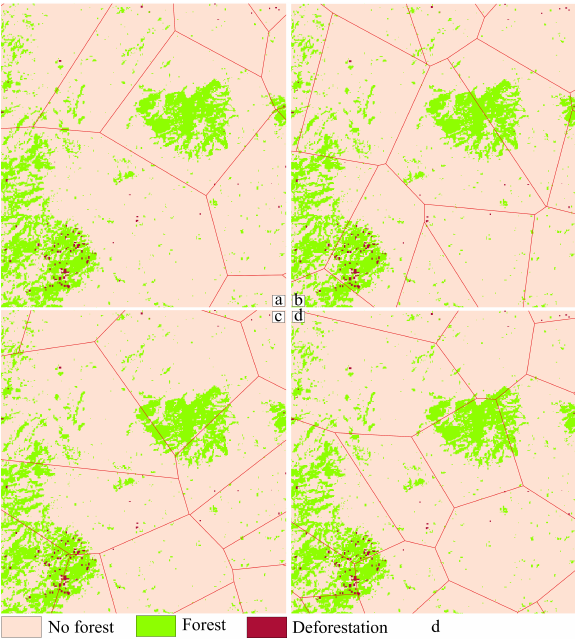
Figure 4: Four configurations of aggregation units (”pseudo mu- nicipalities”) with the same number of units (zoning